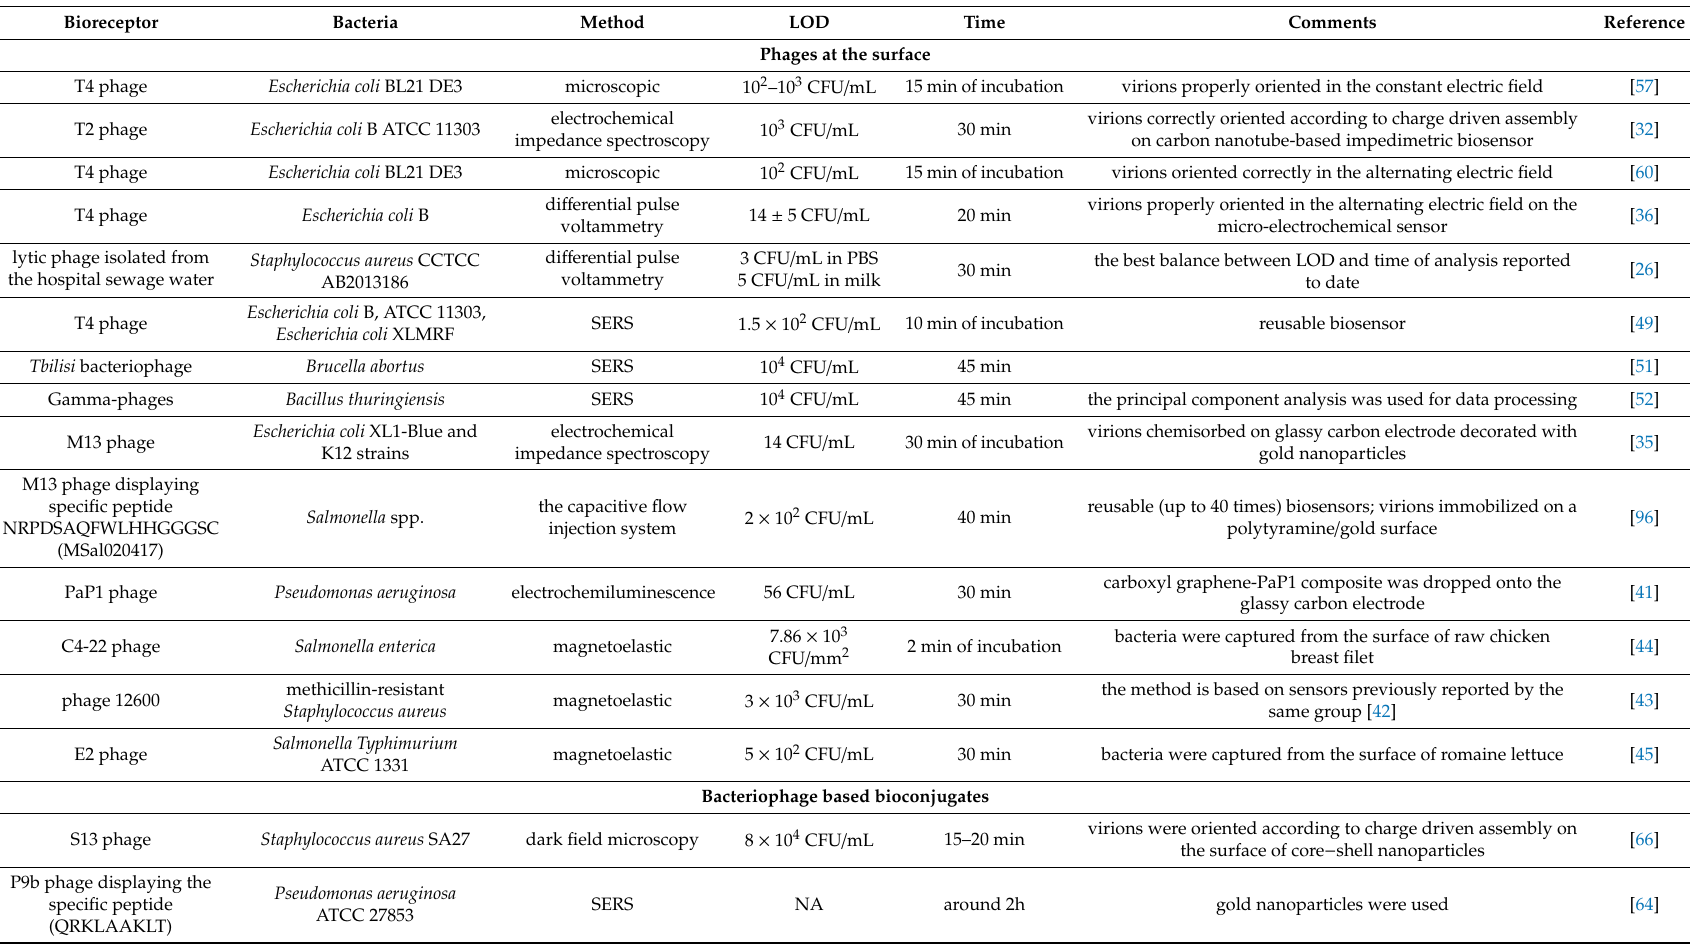
Table 1. Summary of recent developments in phage-based sensors for bacteria